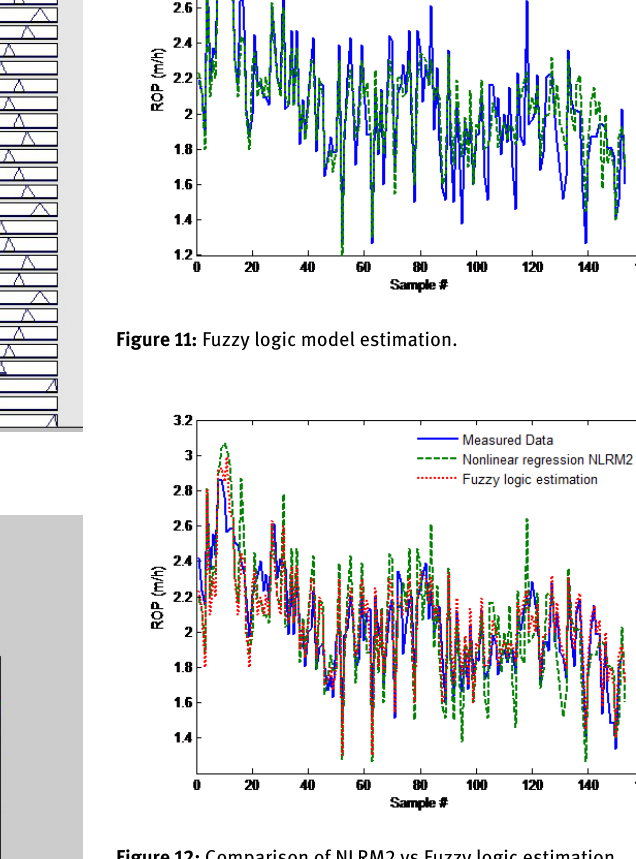
Figure 12: Comparison of NLRM2 vs Fuzzy logic